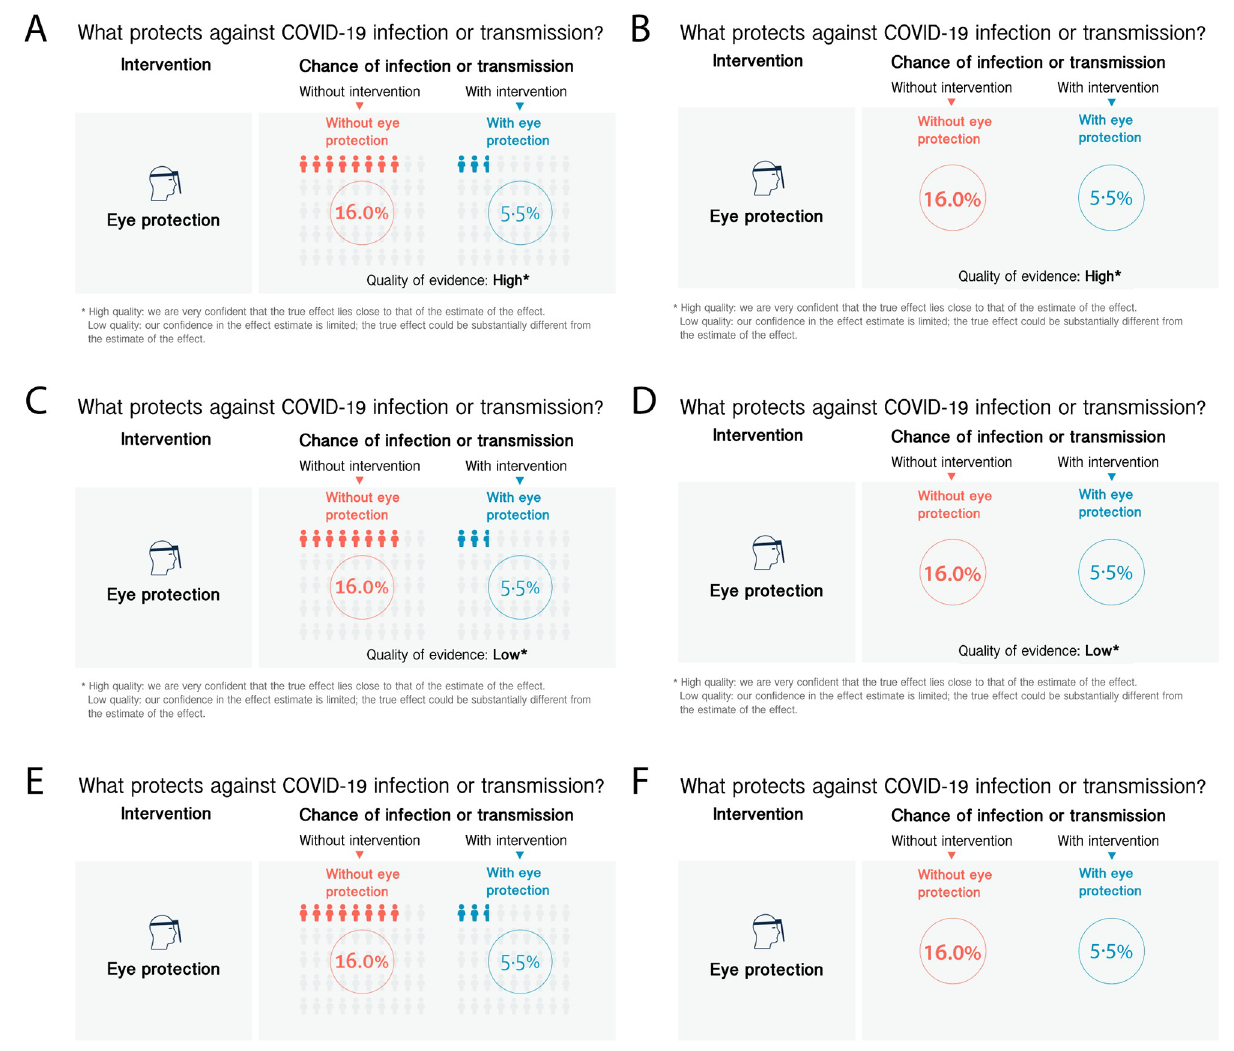
Fig 3. Infographics used in Experiment 2 showing the chance of infection or transmission of COVID-19 without and with eye protection (in two information presentation formats) along with information on the underlying quality of evidence levels. The six panels depict the infographics used for the six experimental conditions. (A) infographic shown to participants in the ‘With Icon Array High Quality of Evidence’ condition, (B) ‘Without Icon Array High Quality of Evidence’ condition, (C) ‘With Icon Array Low Quality of Evidence’ condition, (D) ‘Without Icon Array Low Quality of Evidence’ condition, (E) ‘With Icon Array No Quality of Evidence’ condition, (F) ‘Without Icon Array No Quality of Evidence’